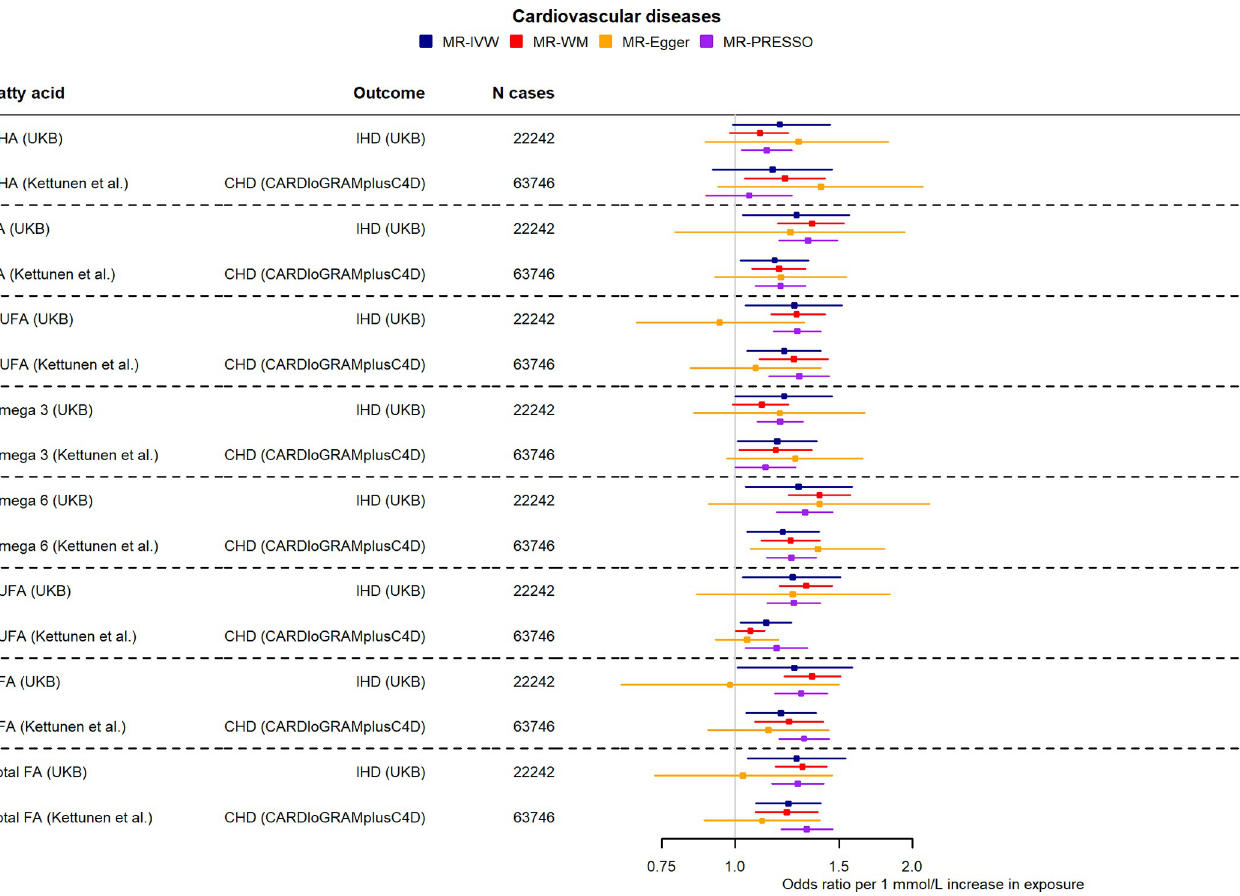
Fig 5. Two-sample MR effect estimates per 1 mmol/L higher fatty acids for different CVD outcomes in (a) UKB (angina pectoris, coronary atherosclerosis, ischemic heart disease) and (b) using Kettunen and colleagues’ [20] betas for fatty acids and CARDIOGRAMplusC4D [22] for ischemic heart disease. Estimates of all examined fatty acids are shown for comparison. CVD, cardiovascular disease; DHA, docosahexaenoic acid; LA, linoleic acid; MUFA, monounsaturated fatty acid; PUFA, polyunsaturated fatty acid; SFA, saturated fatty acid; total FA, total fatty acid; UKB, UK Biobank; WM, weighted-median.